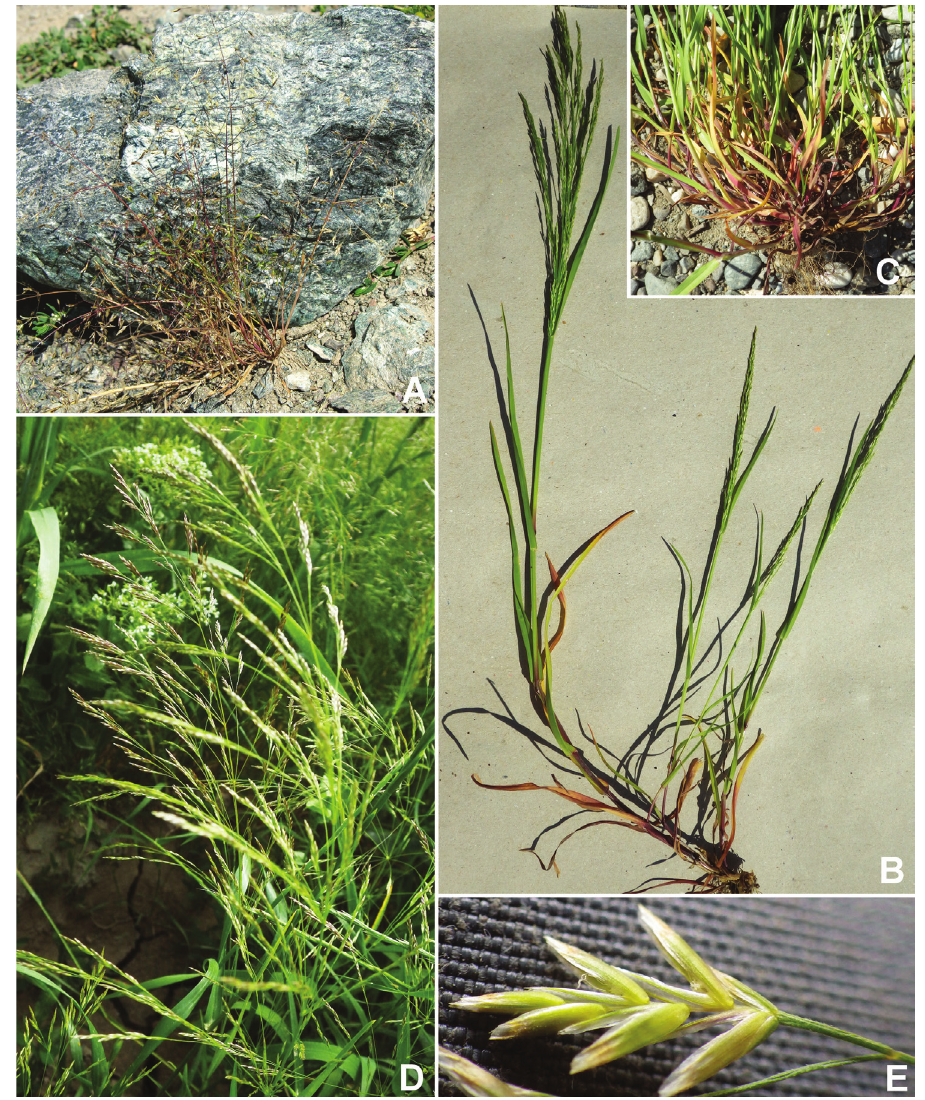
Figure 3. Poa subgenus Pseudopoa sect. Pseudopoa. A P. diaphora subsp. diaphora var. diaphora , Chu, Kyrgyz Republic ( Soreng et al. 7537 ) B, C P. persica subsp. persica , Adiyaman, Turkey ( Soreng et al. 9215 ) B habit C closeup of base of plant showing keeled leaf sheaths and caniculate blades D, E P. persica subsp. multiradia- ta , Mardin, Turkey ( Soreng et al. 9240 ) D habit E spikelet showing glabrous lemmas. Photos by R.J. Soreng.